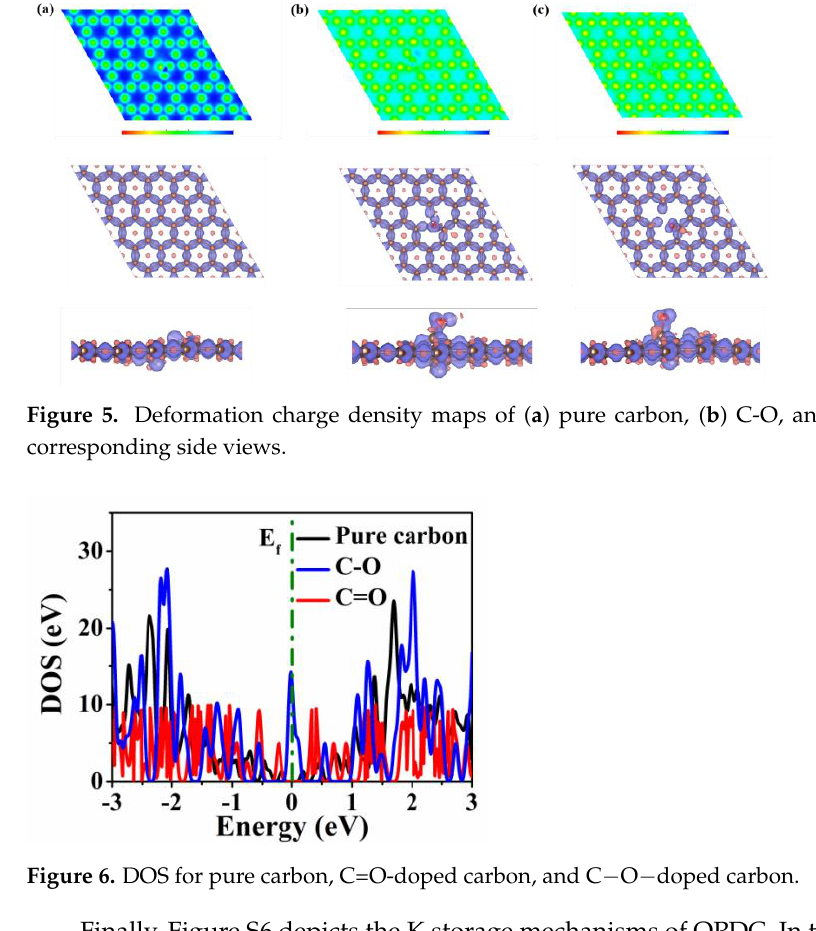
Figure 4. Adsorption of K − ions on ( a ) pure carbon, ( b ) C − O, and ( c ) C=O and the corresponding side views. Brown indicates C atoms, pink indicates H atoms, red indicates O atoms, and purple indi- cates K atoms.